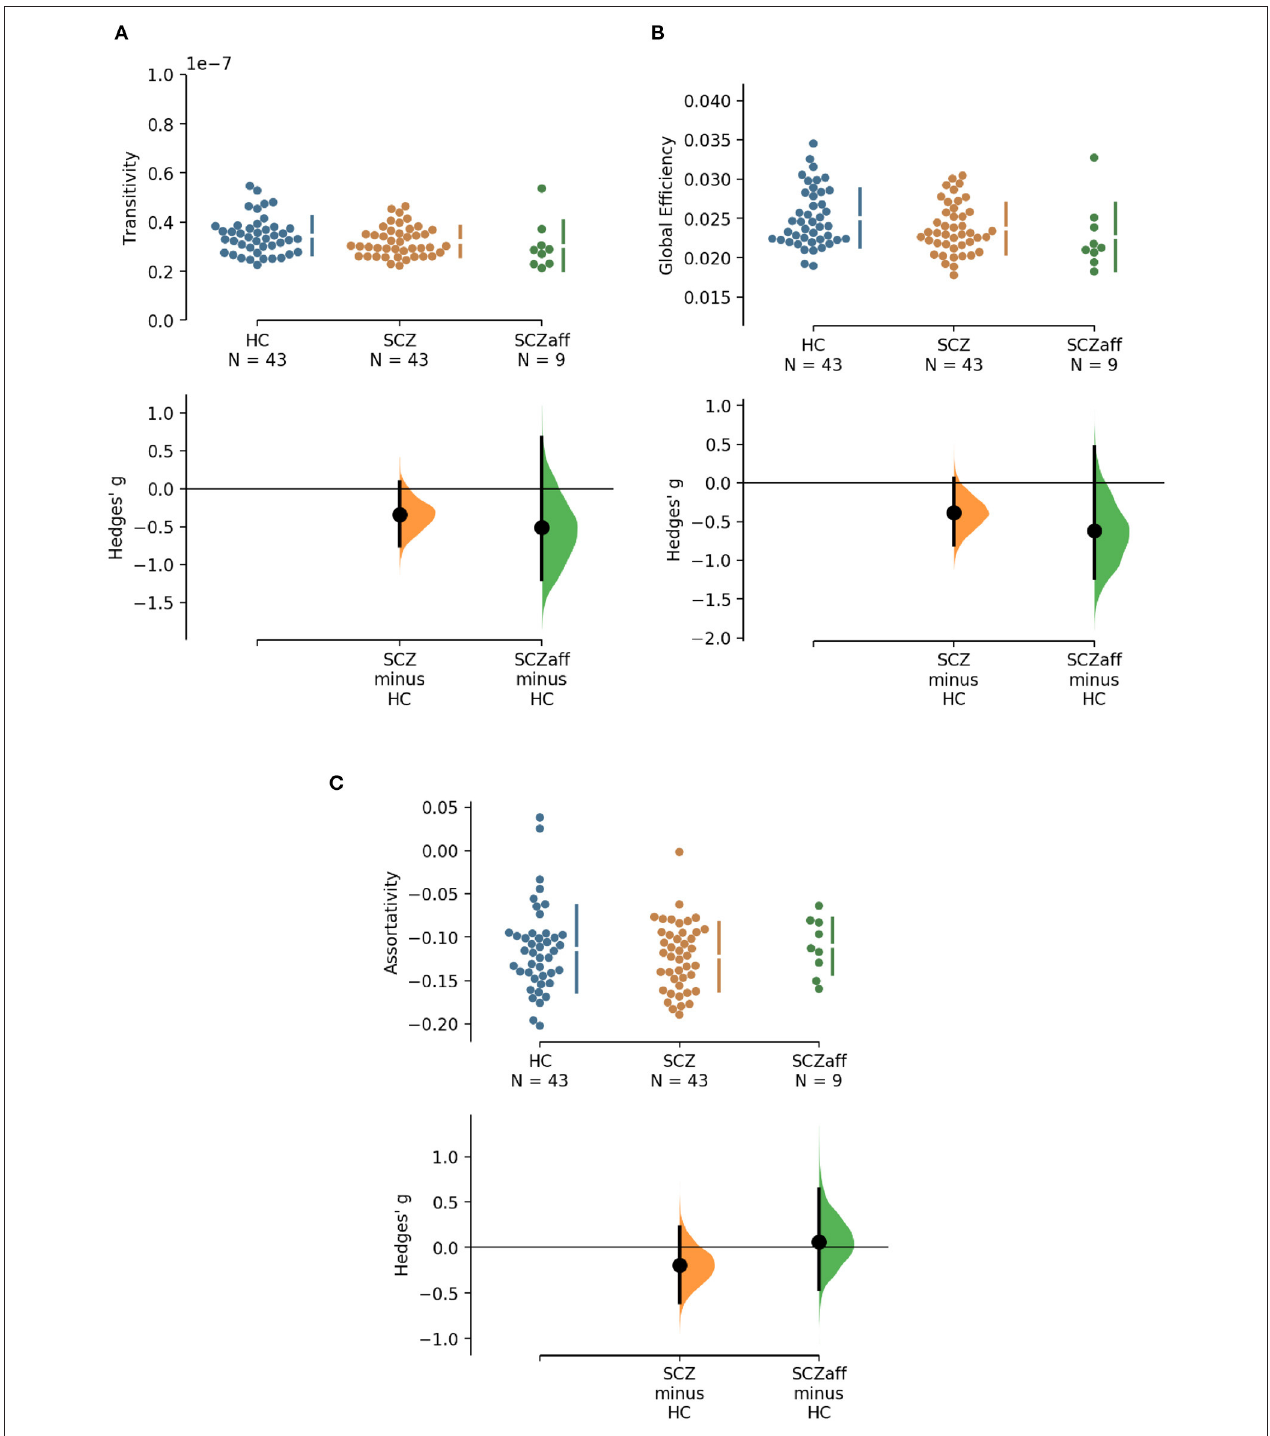
FIGURE 2 | Hedge’s g for the comparisons of various graph measures for the SCZ and SCZaff groups against the HC group are shown in the above Cumming estimation plot. The raw data is plotted on the upper axes. On the lower axes, mean differences are plotted as bootstrap sampling distributions. Each mean difference is depicted as a dot. Each 95% confidence interval is indicated by the ends of the vertical error bars [see (30)]. Panels show (A) transitivity (measure of segregation), (B) global efficiency (measure of integration), and (C) assortativity (measure of resilience).